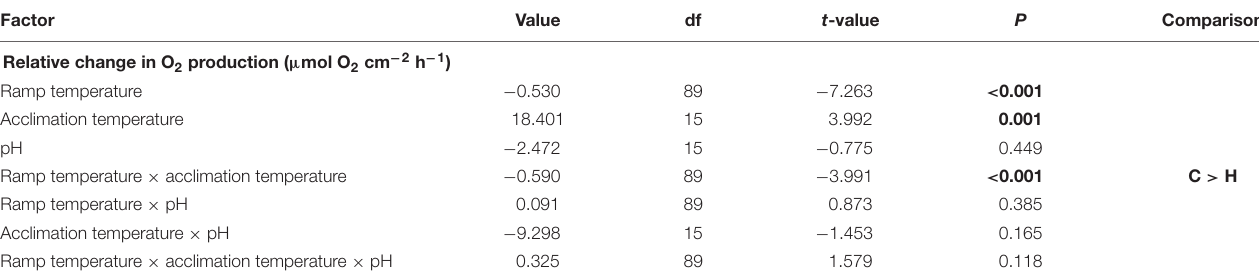
FIGURE 1 | Average net photosynthesis ( µ mol O 2 cm − 2 h − 1 ) of Porolithon cf. onkodes after a 6-week acclimation period to constant, experimental levels of temperature and/or pH (27.2 or 29.5 ◦ C and pH 8.0 or 7.7). Each bar is mean O 2 production per treatment ± standard error (SE). n = 4–5. Blue bars equate to control temperature, 27.2 ◦ C, and yellow hued bars to elevated temperature, 29.5 ◦ C, with pH treatment shown as different shades within temperature treatment. p values for the effect of temperature ( T ), pH, and the interaction between temperature and pH ( T × pH) are listed from Supplementary Table 2 within the figure. TABLE 1 | Summary of statistical information from a linear mixed effects model with a random intercept on the relative change of O 2 production during the acute warming experiment. Factor Value df t -value P